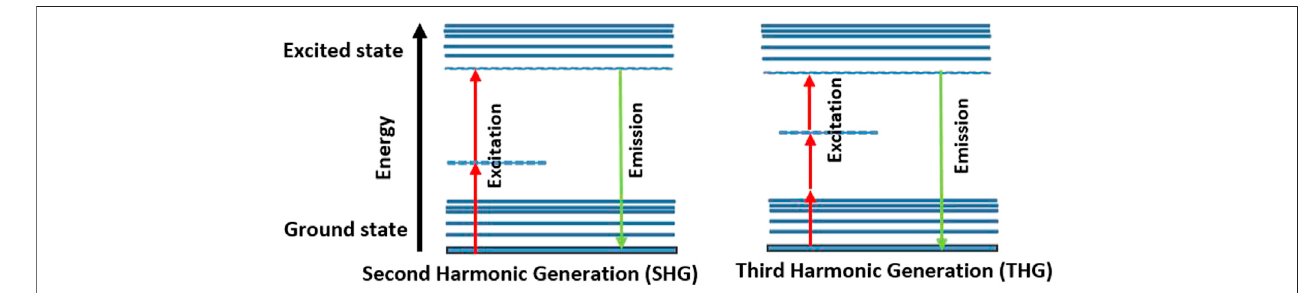
FIGURE 1 | Illustration of SHG and THG process.